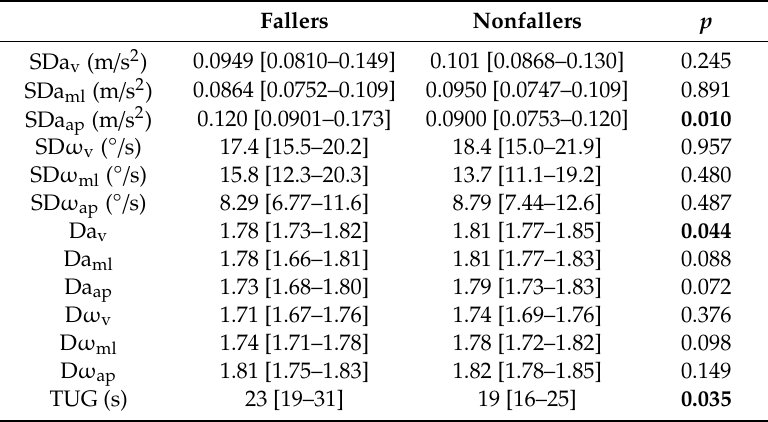
Table 2. Comparison between various indices of fallers and nonfallers at t 1 . Data are given under the form median [1st quartile–3rd quartile]. SD = standard deviation, D = fractal dimension. These indices are followed by a subscript labeling the time series from which it was obtained. Results of the TUG test are given in the last line. Significant differences are written in bold font.